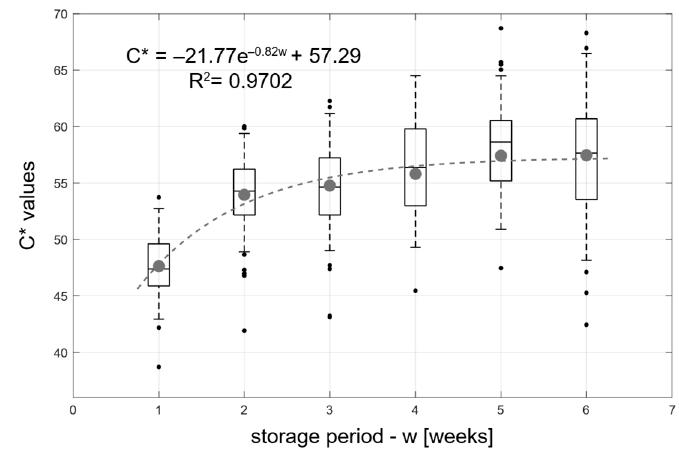
Figure 7. Chroma (C*) values during storage at the ambient temperature of apple. Apples lose their green skin and flesh color during maturity as chlorophyll is lost.